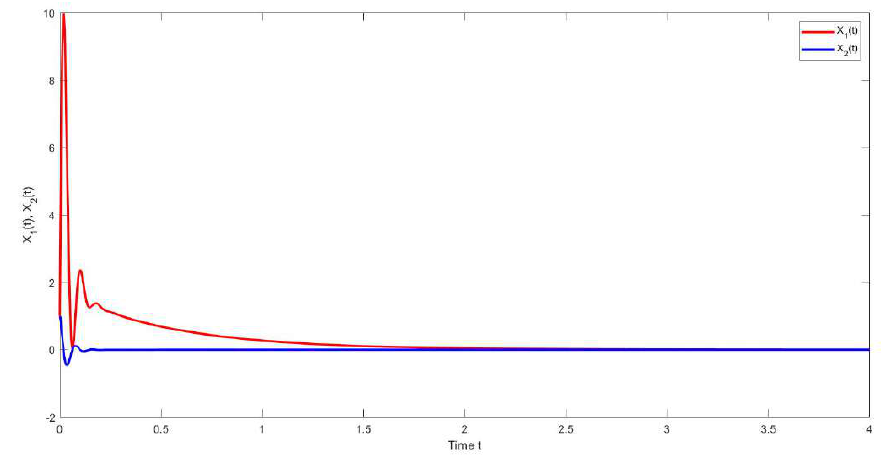
Figure 2. Trajectory of the state X ( t ) solution of System (67)–(71).